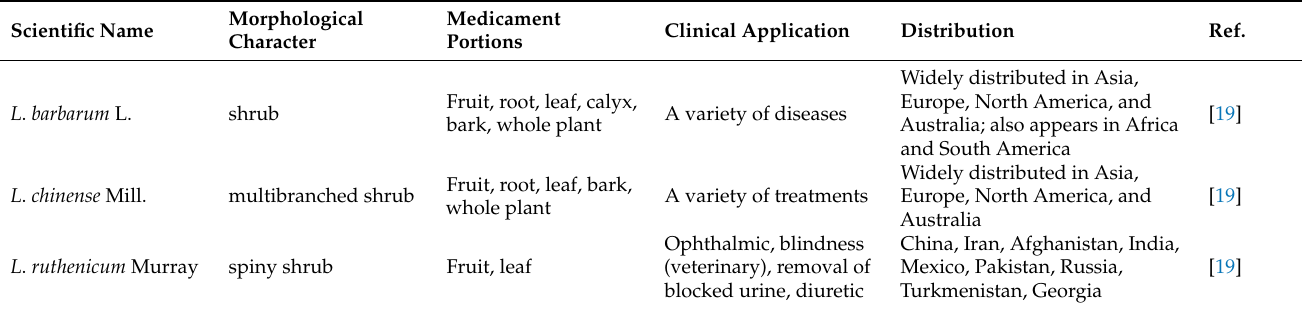
Table 1. Characteristics and distribution of Lycium L. from different